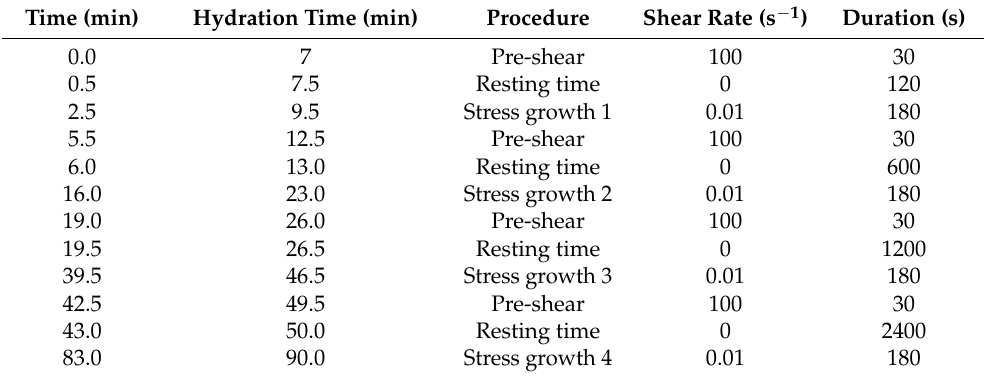
Table 3. The proposed testing method for the chemical structural build-up (Procedure